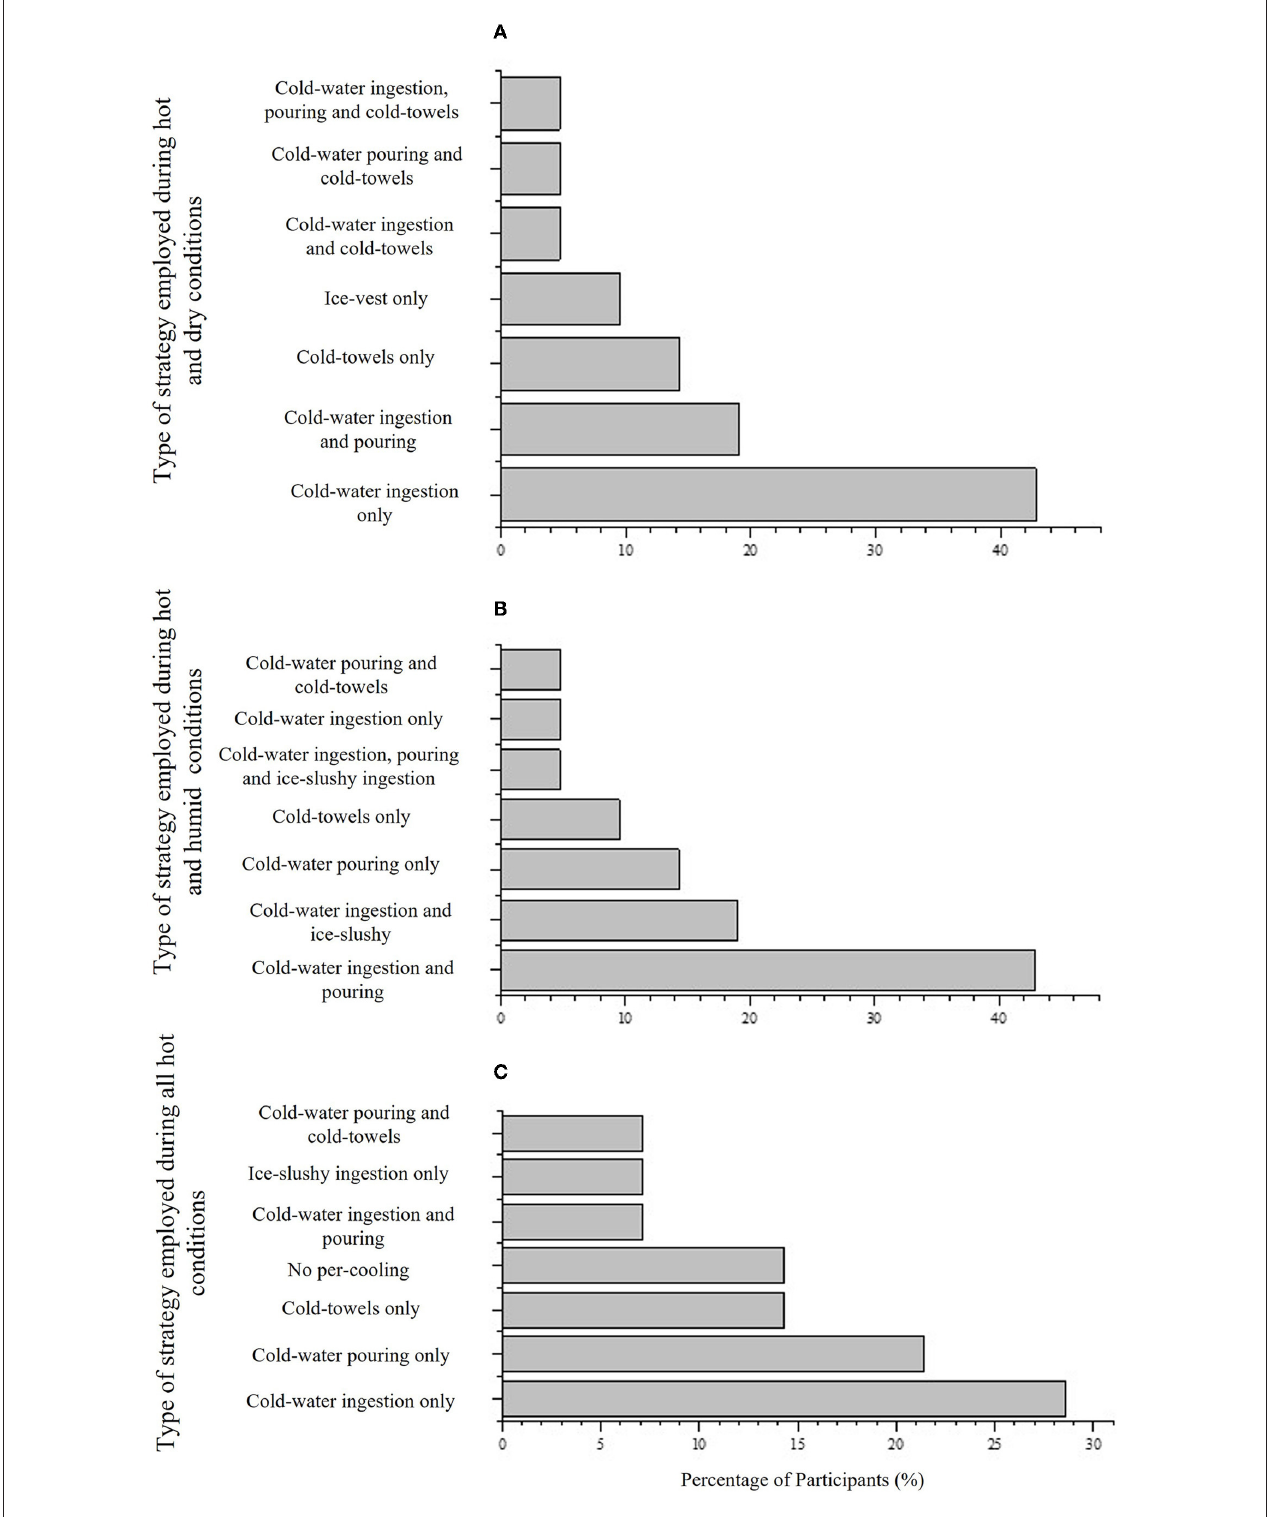
FIGURE 3 | (A) Strategies employed in hot and dry conditions by 60% ( N = 21) participants who use different strategies depending on condition, (B) strategies employed in hot and humid conditions by 60% ( N = 21) participants who use different strategies depending on condition, and (C) strategies employed in all hot conditions by 40% ( N = 14) participants who employed the same strategy regardless of condition.